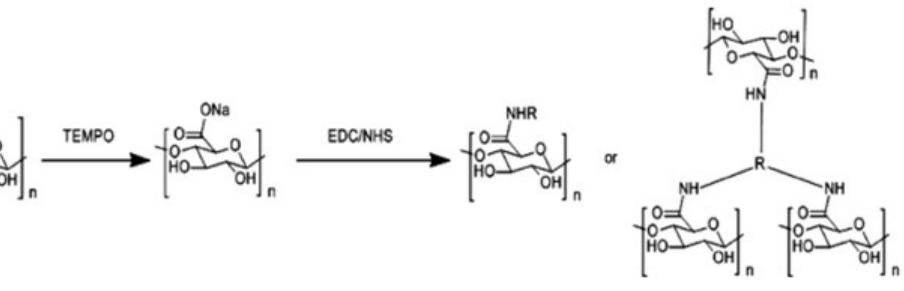
Figure 8. Oxidation and amidation of ultra-fine cellulose nanofibers. Reproduced with permission from [141], copyright of Elsevier B.V.